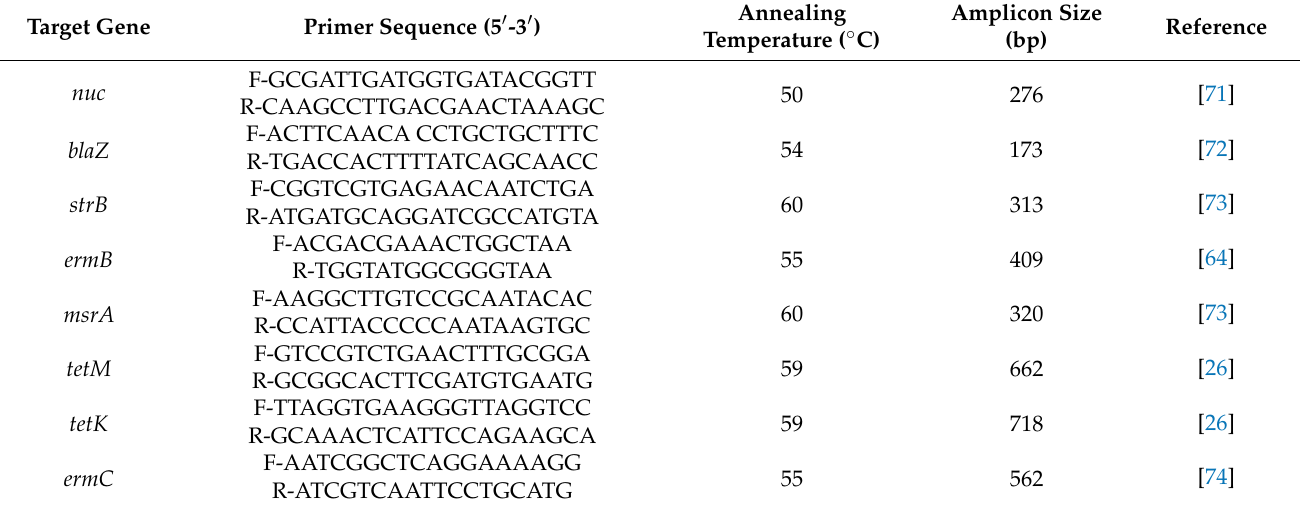
Table 4. Details of primers and annealing temperatures used to detect antibiotic resistance genes in the study. Target